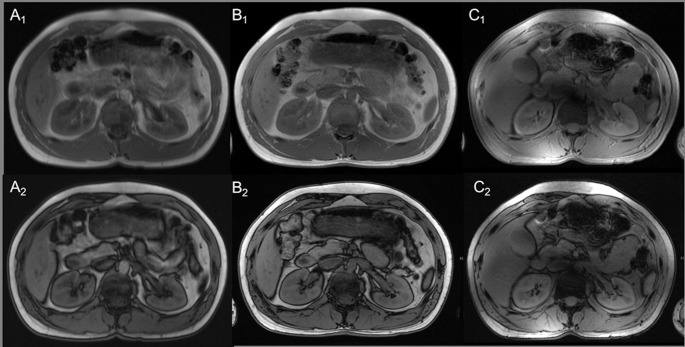
T1-weighted 2D in and opposed phase.T1-weighted 2D in and opposed phase imaging at 1.5 Tesla (A1,2) 3 Tesla (B1,2) and 7 Tesla (C1,2) in the same subject. The typical black rims with a fat/water interface around organs are increasingly sharp and clear visualized in the opposed phase images at 3 and 7 Tesla, compared to 1.5 Tesla and are also visible in the in phase images at 7 Tesla. Nevertheless, strong signal voids due to RF shimming are detectable in the periaortal region at 7 Tesla images. The expected exacerbation of chemical shifting (3.77Tesla, 4.43Tesla, 4.51.5Tesla) associated to the increase of the magnetic field strength resulted in insignificantly decreased mean values of overall image quality and impairment at 7 Tesla compared to 1.5 and 3 Tesla (4.27Tesla, 4.43Tesla, 4.61.5Tesla). Additionally 7 Tesla MRI was relatively strongly impaired due to residual B1 inhomogeneities (3.77Tesla, 4.53Tesla, 4.81.5Tesla). Being a T1w gradient echo sequence, in and opposed phase imaging also provided moderate to high-quality delineation of the non-enhanced vasculature at 7 Tesla (3.87Tesla, 2.13Tesla, 1.91.5Tesla). In accordance to the previous T1w sequences, 7 Tesla demonstrated higher contrast ratios compared to 3 Tesla and 1.5 Tesla for all organs with highest difference for the left kidney (CR7Tesla 0.35, CR3Tesla 0.12, CR1.5Tesla 0.07), p<0.012 respectively. For the right liver lobe S6 (CR7Tesla 0.19, CR3Tesla 0.16, CR1.5Tesla 0.14) and the spleen (CR7Tesla 0.17, CR3Tesla 0.16, CR1.5Tesla 0.09), 7 Tesla revealed slightly higher values without statistical significance (p values from 0.326–1).